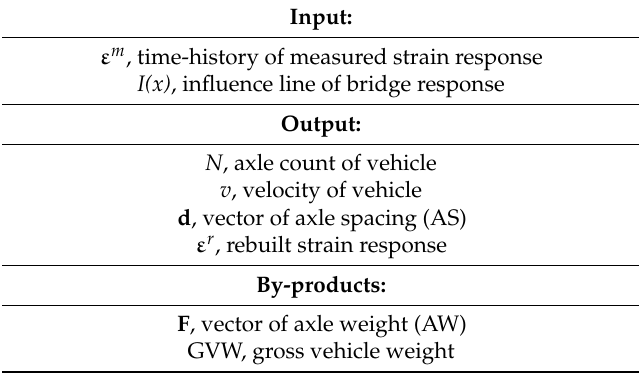
Table 1. Input and output data of the BwimNet